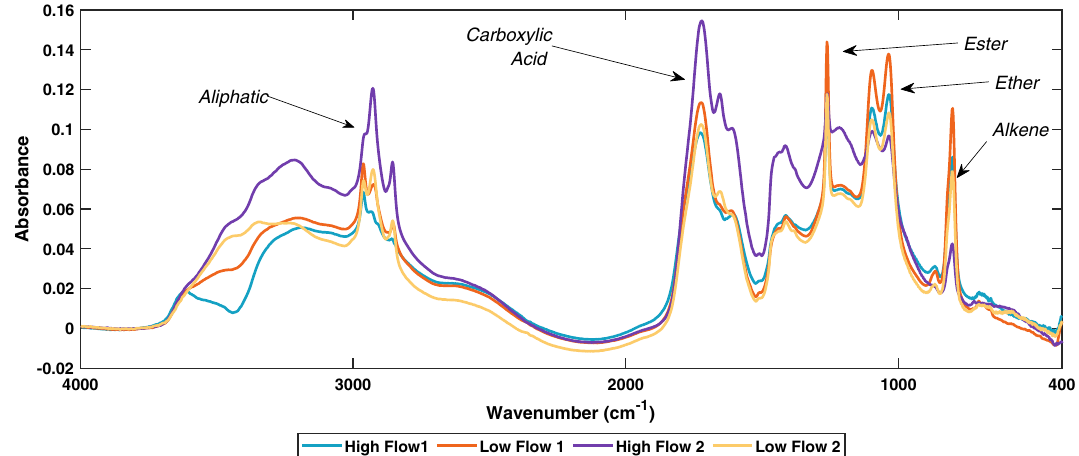
Figure 2. FTIR spectrum of SPE-DOM of the four sampling dates. Samples were measured using KBr pellets and analysed on a Bruker Alpha FTIR. The resolution was at 4 cm/s for a total of 24 scans. Spectra were corrected using a methanol blank and two-point offset correction.